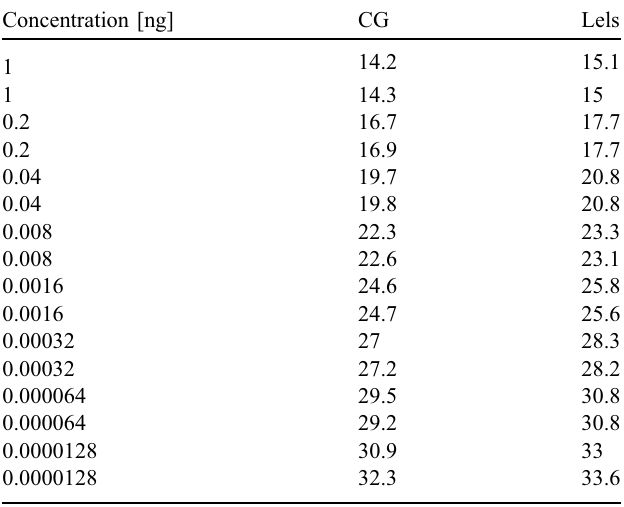
Table 3. Number of qPCR quanti fi cation cycles obtained by DNA of the seawater samples (Average± standard deviation, N =3). n.d.=